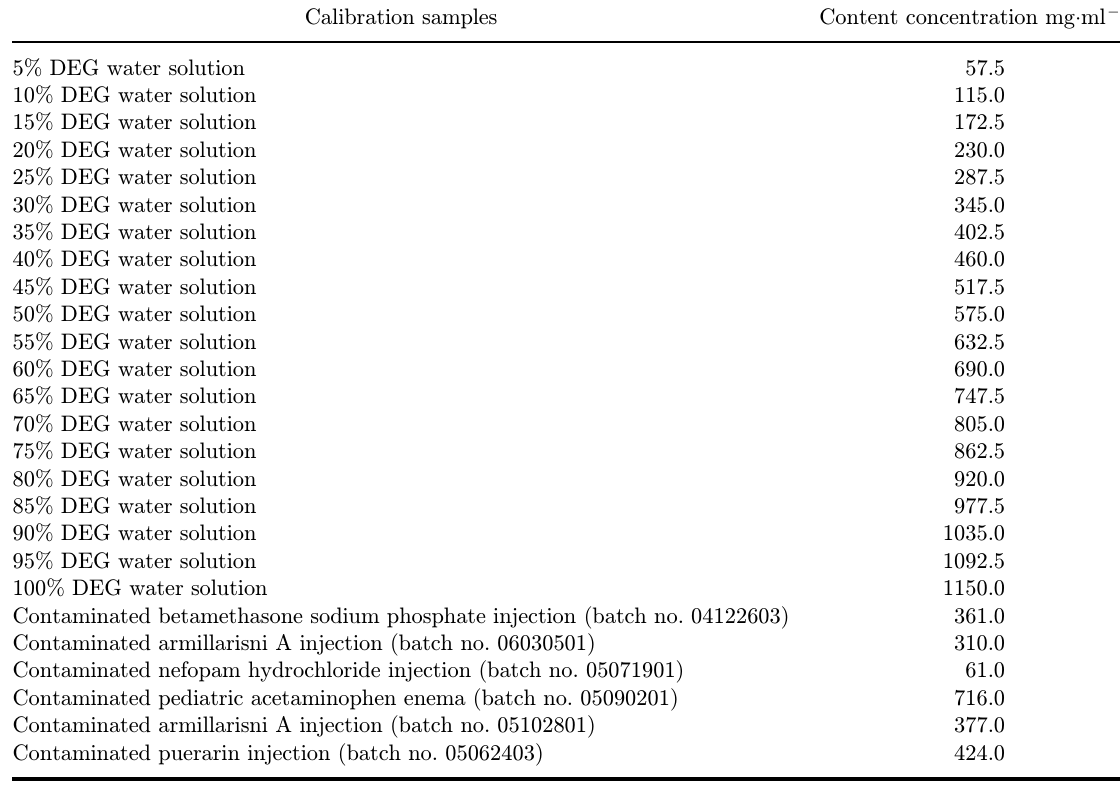
Table 3. DEG concentration of 26 samples for developing calibration model.